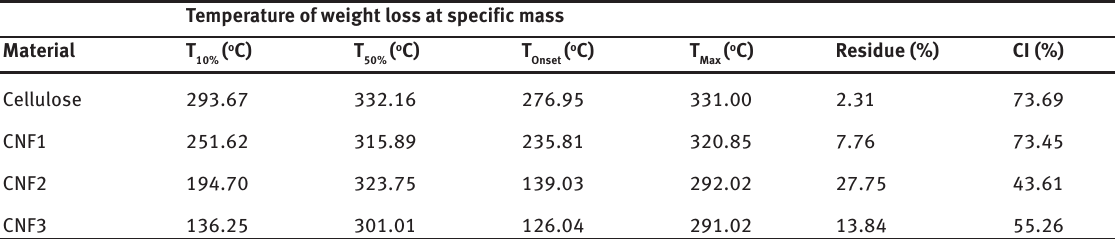
Table 3: Thermal analysis data of α-cellulose, CNF1, CNF2 and CNF3. Temperature of weight loss at specific